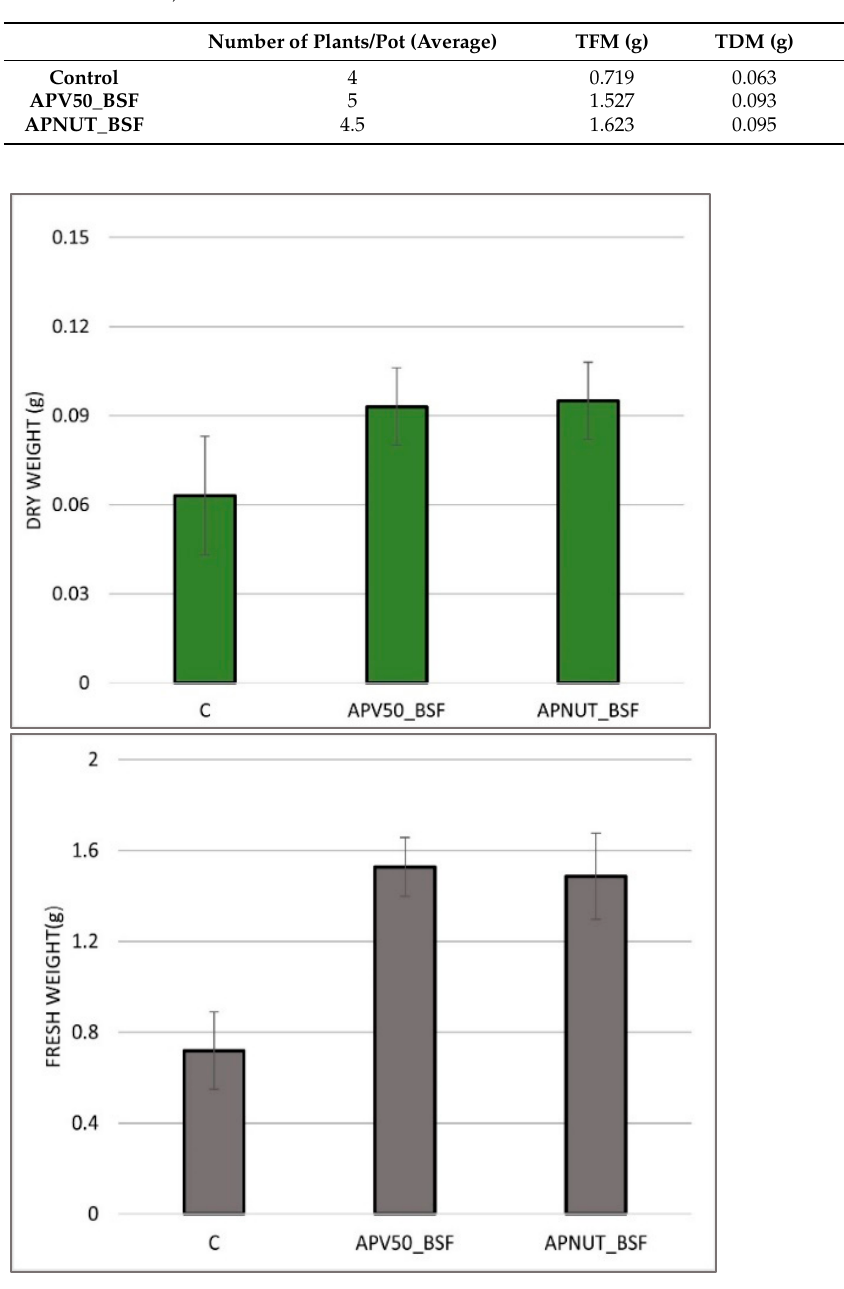
Figure 6. Lettuce biomass measured within 21 days of cultivation in pots with fertilizer APV50_BSF and APNUT_BSF and without fertilizer (C). The error bars represent the deviation standard calculated on the values measured.